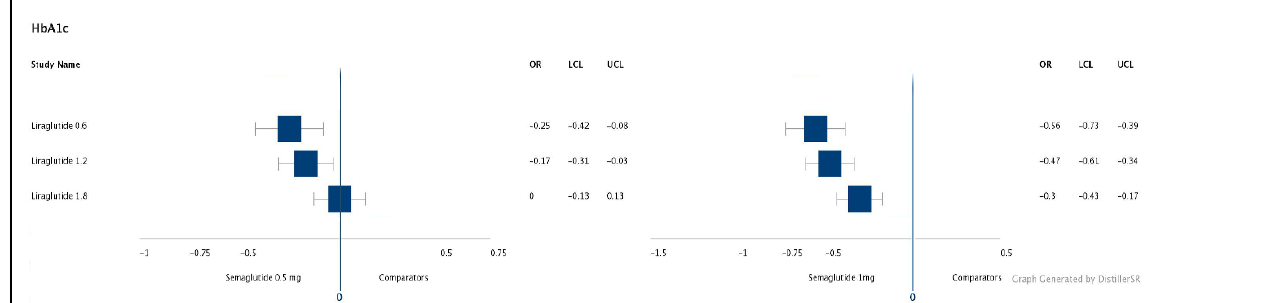
highest score, blue is the second highest, and grey is not included.